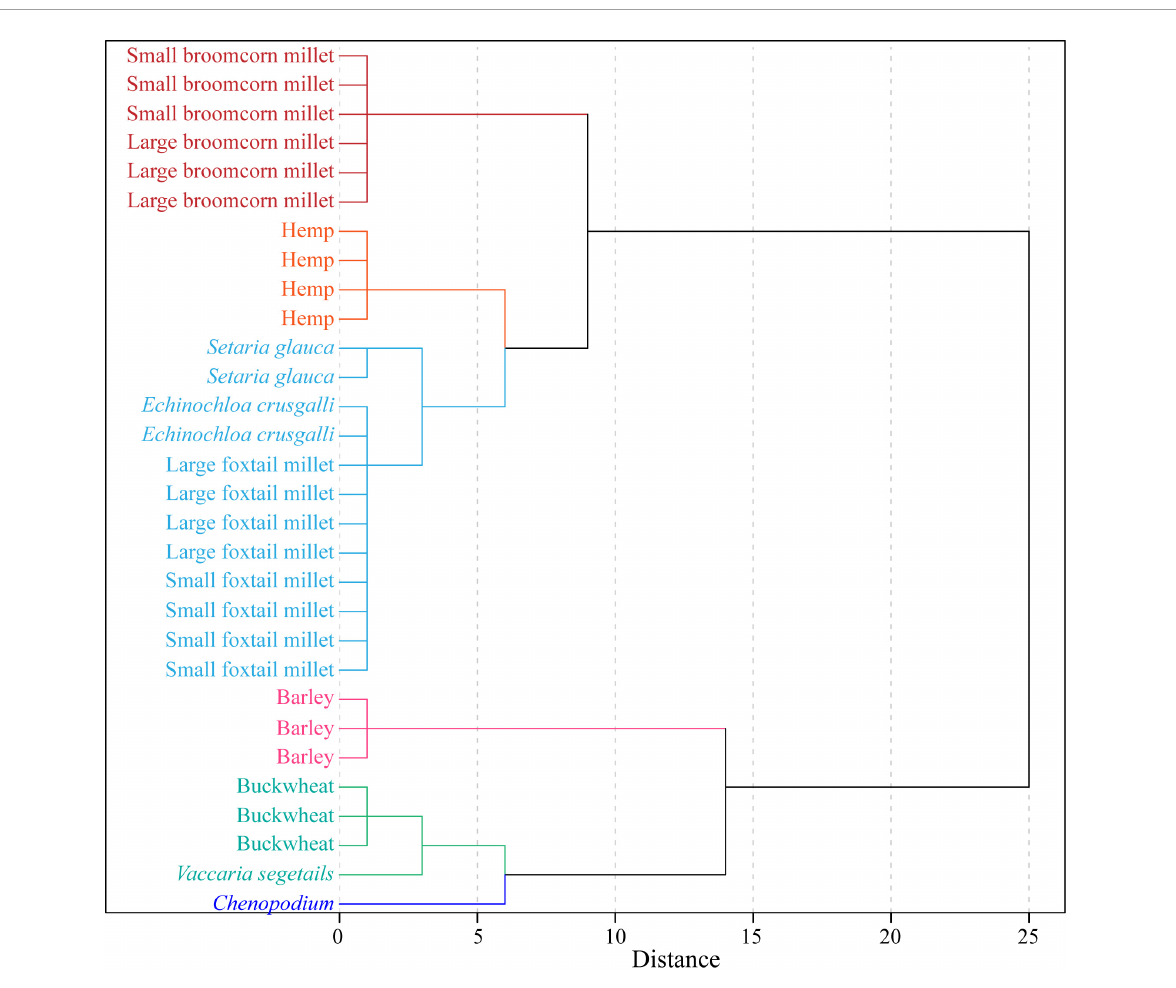
FIGURE6 Element clustering analysis of plant remain samples from the Chashancun